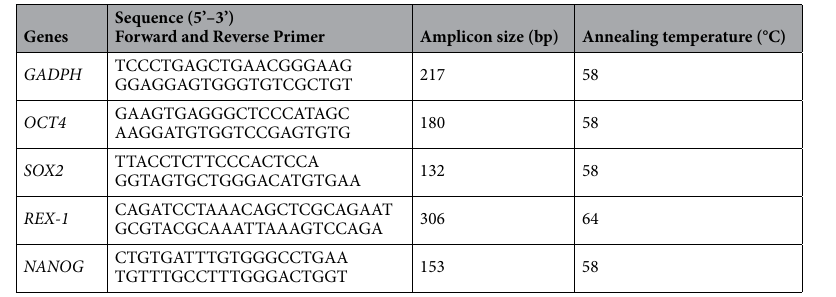
Table 2. Primer sequence of the pluripotent genes and the PCR product size.